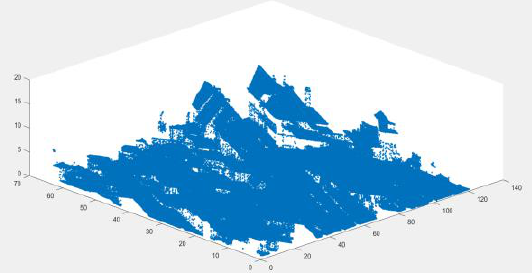
Figure. 4. LiDAR points cloud from IEEE with high resolution